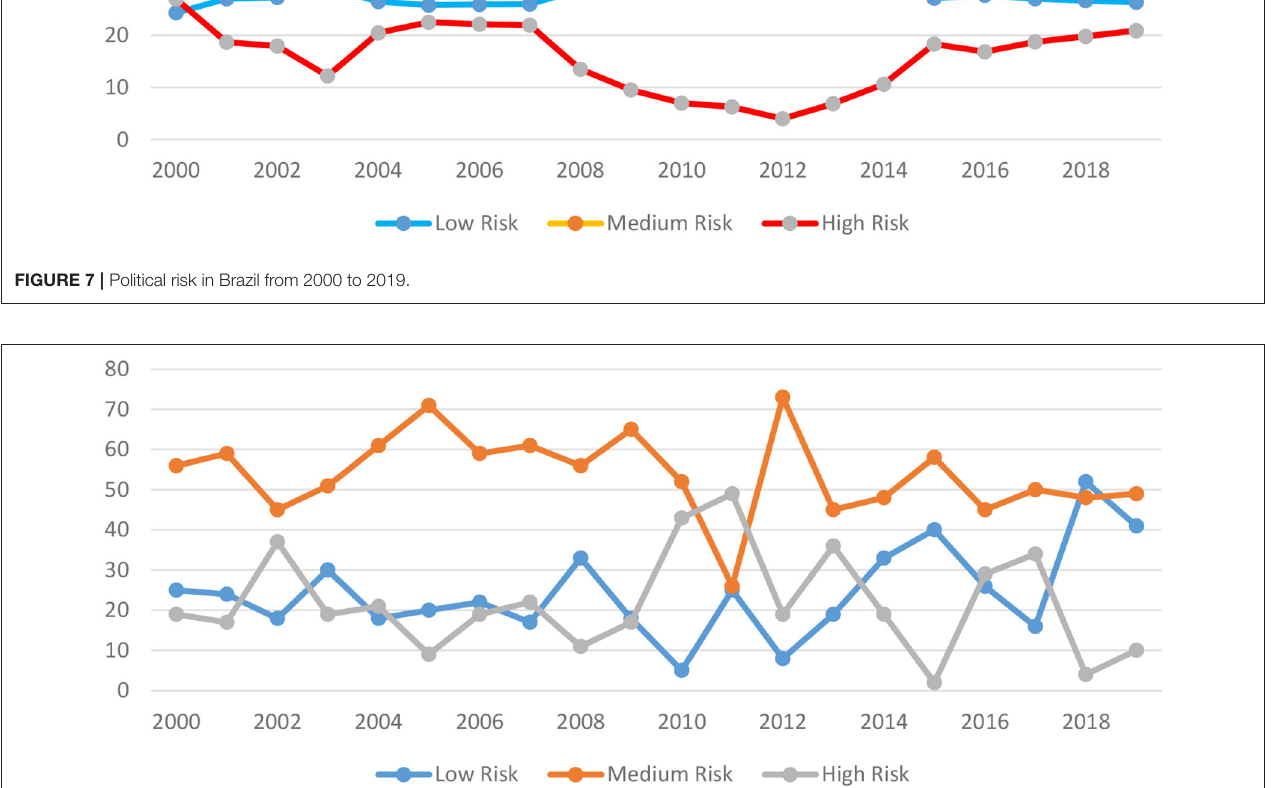
FIGURE 8 | Economical risk in Brazil from 2000 to